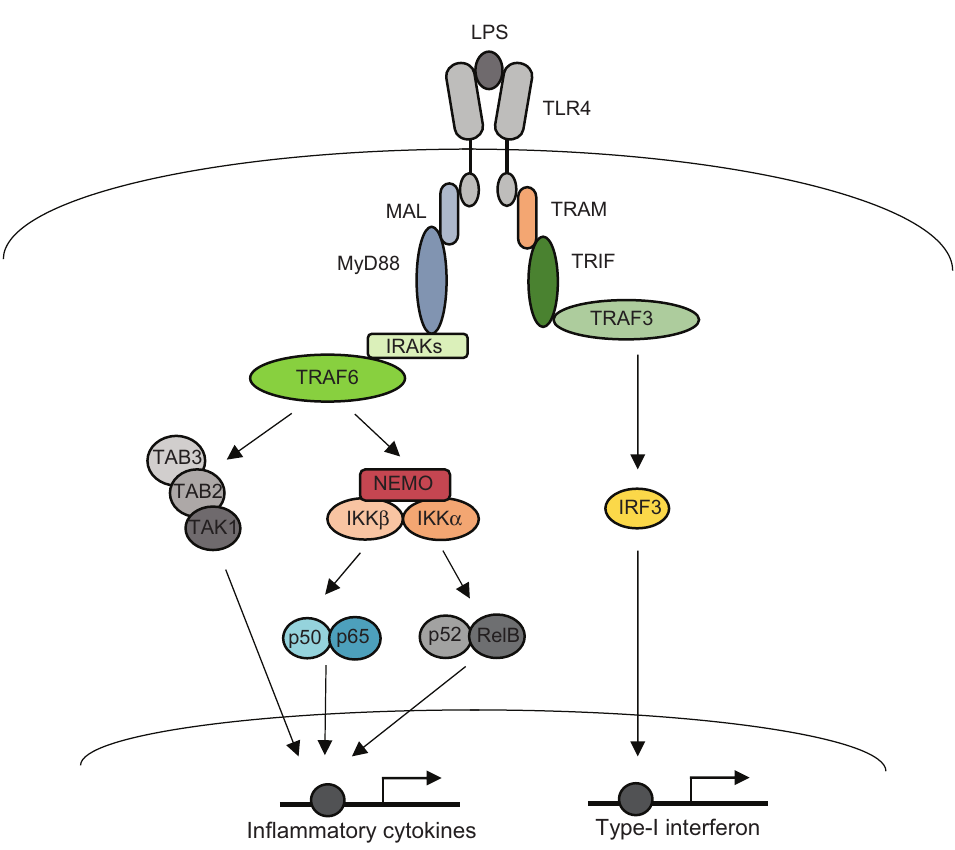
Figure 1. Toll-like receptors (TLR) 4-mediated signaling of innate immune responses. Binding of lipopolysaccharide (LPS) to TLR4 initiates a signaling complex by the recruitment of MyD88 and TIR domain-containing adaptor protein inducing IFN-(cid:4) (TRIF), to the receptor. The MyD88-dependent signaling pathway activates transcriptional activation of pro-inflammatory cytokines via the activation of both NF-(cid:2)B and mitogen-activated protein kinase (MAPK) s. The MyD88-independent pathway is mediated by TRIF and culminates in the production of type-1 interferons